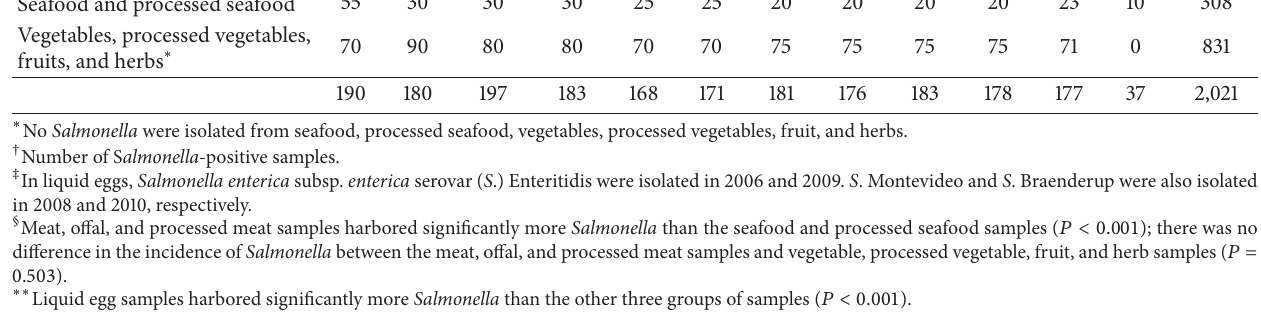
Table 2: Salmonella -positive rates among meat, offal, and processed meat